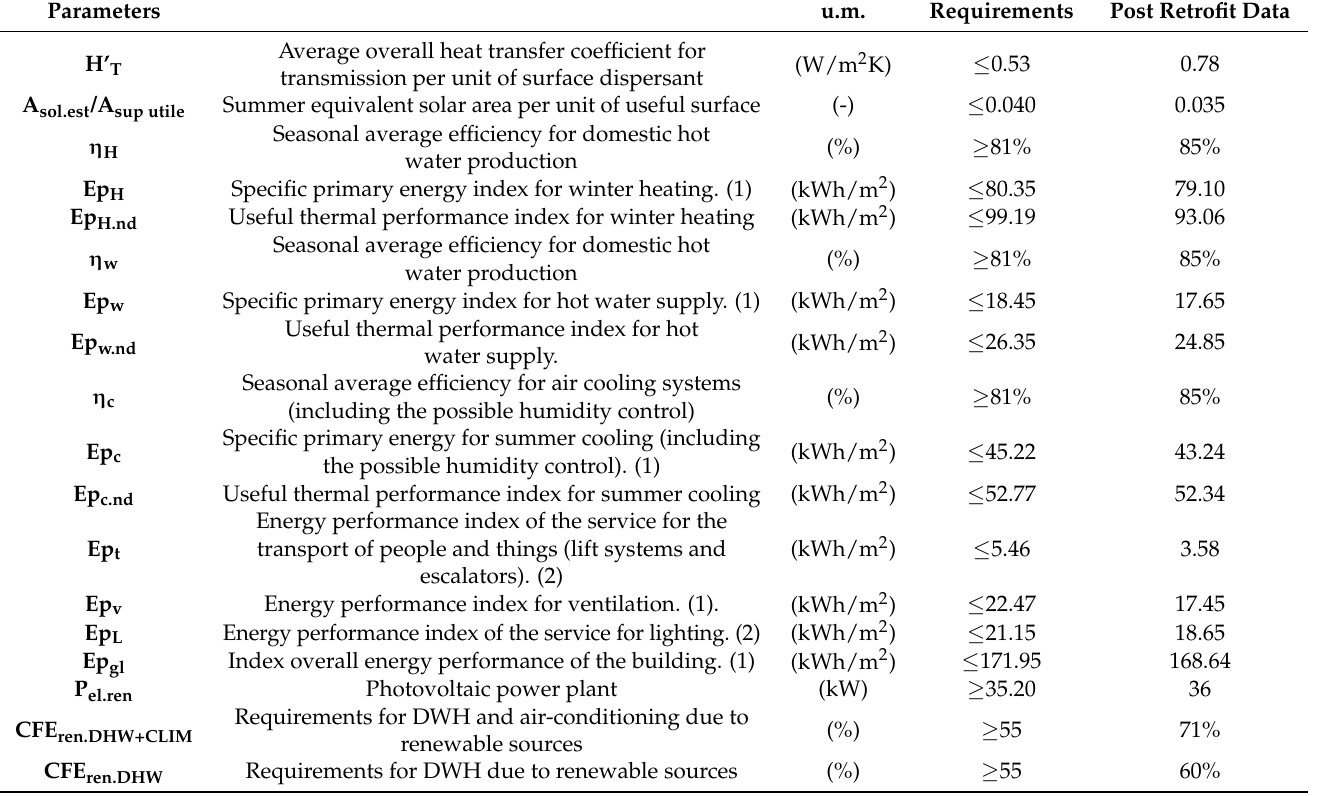
Table 11. Italian standard parameters nZEB post retrofit efficiency with 36 kW PV